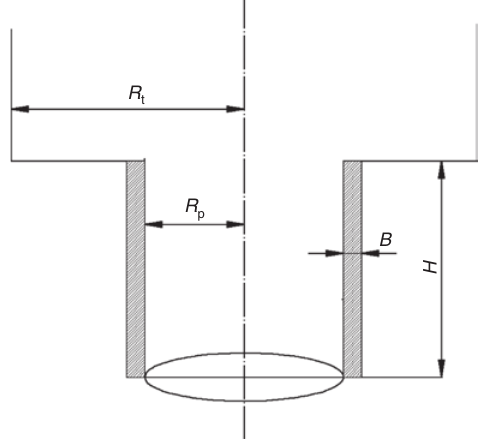
Figure 7: Plastic flow layer around the